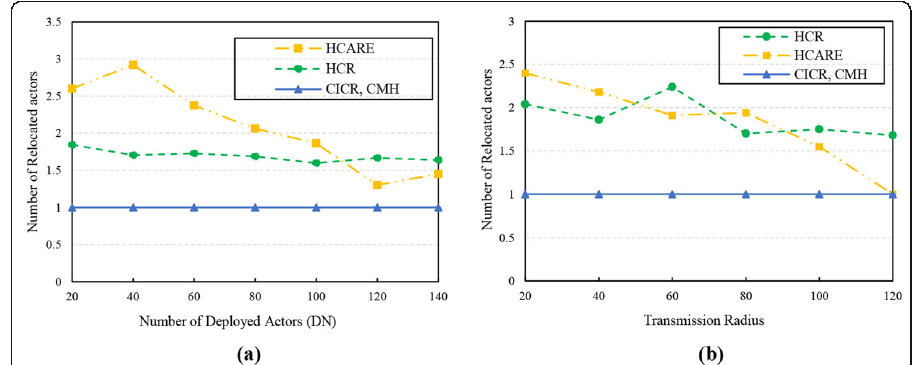
Fig. 7 Average number of relocated actors with varying ( a ) average number of actors (fixed R c = 80), ( b ) the transmission radius (fixed DN =